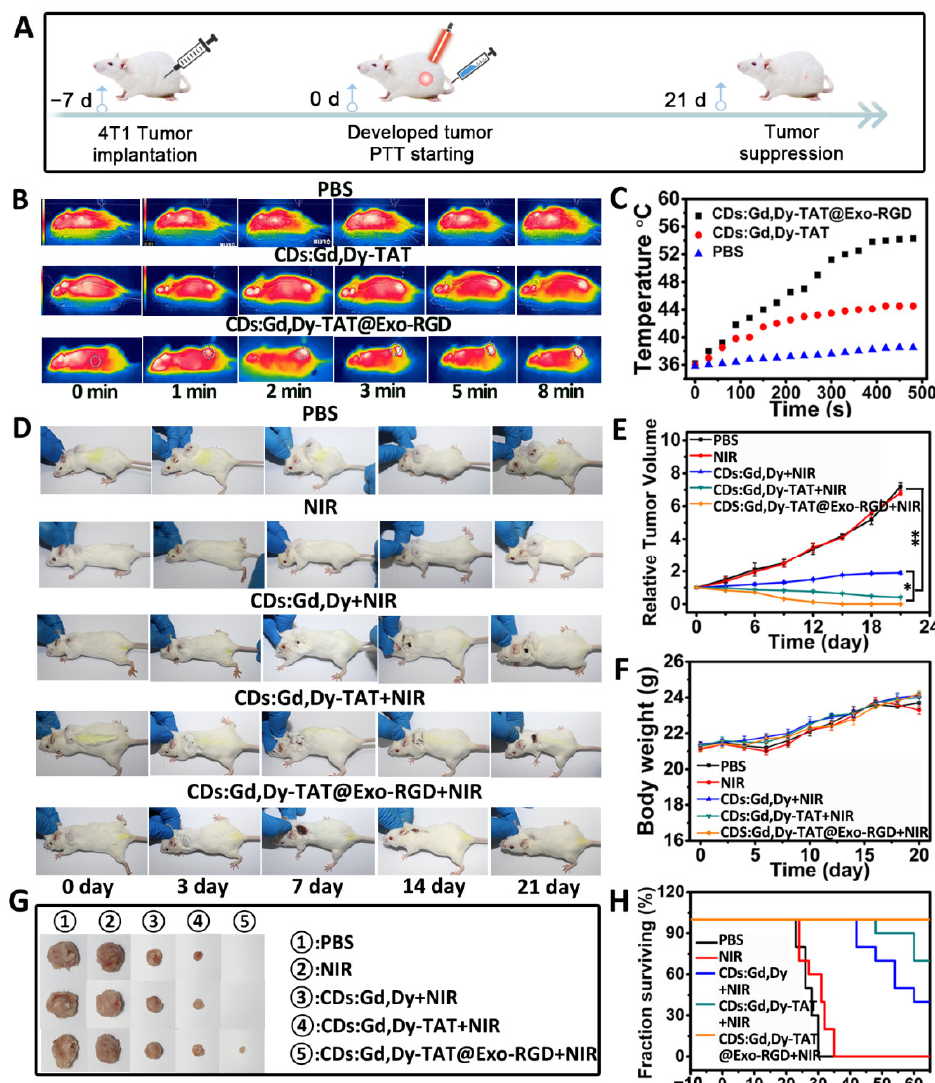
Figure 6. In vivo tumor PTT effect of CDs:Gd,Dy-TAT@Exo-RGD. ( A ) The schematic illustration of photothermal therapy in vivo. Thermal infrared images ( B ) and the temperature change ( C ) of tumor in tumor-bearing mice injected with PBS, CDs:Gd,Dy-TAT or CDs:Gd,Dy-TAT@Exo-RGD followed by NIR laser irradiation (1.6 W·cm −2 , 8 min). Representative mice photographs ( D ), relative tumor volumes ( E ) and body weights ( F ) of the mice from the PBS, NIR, CDs:Gd,Dy+NIR, CDs:Gd,Dy-TAT+NIR and CDs:Gd,Dy-TAT@Exo-RGD+NIR groups. ( G ) Photographs of tumors collected from different groups at the end of the treatment. ( H ) Survival rate of the mice after different treatments (* p < 0.05, ** p < 0.01).